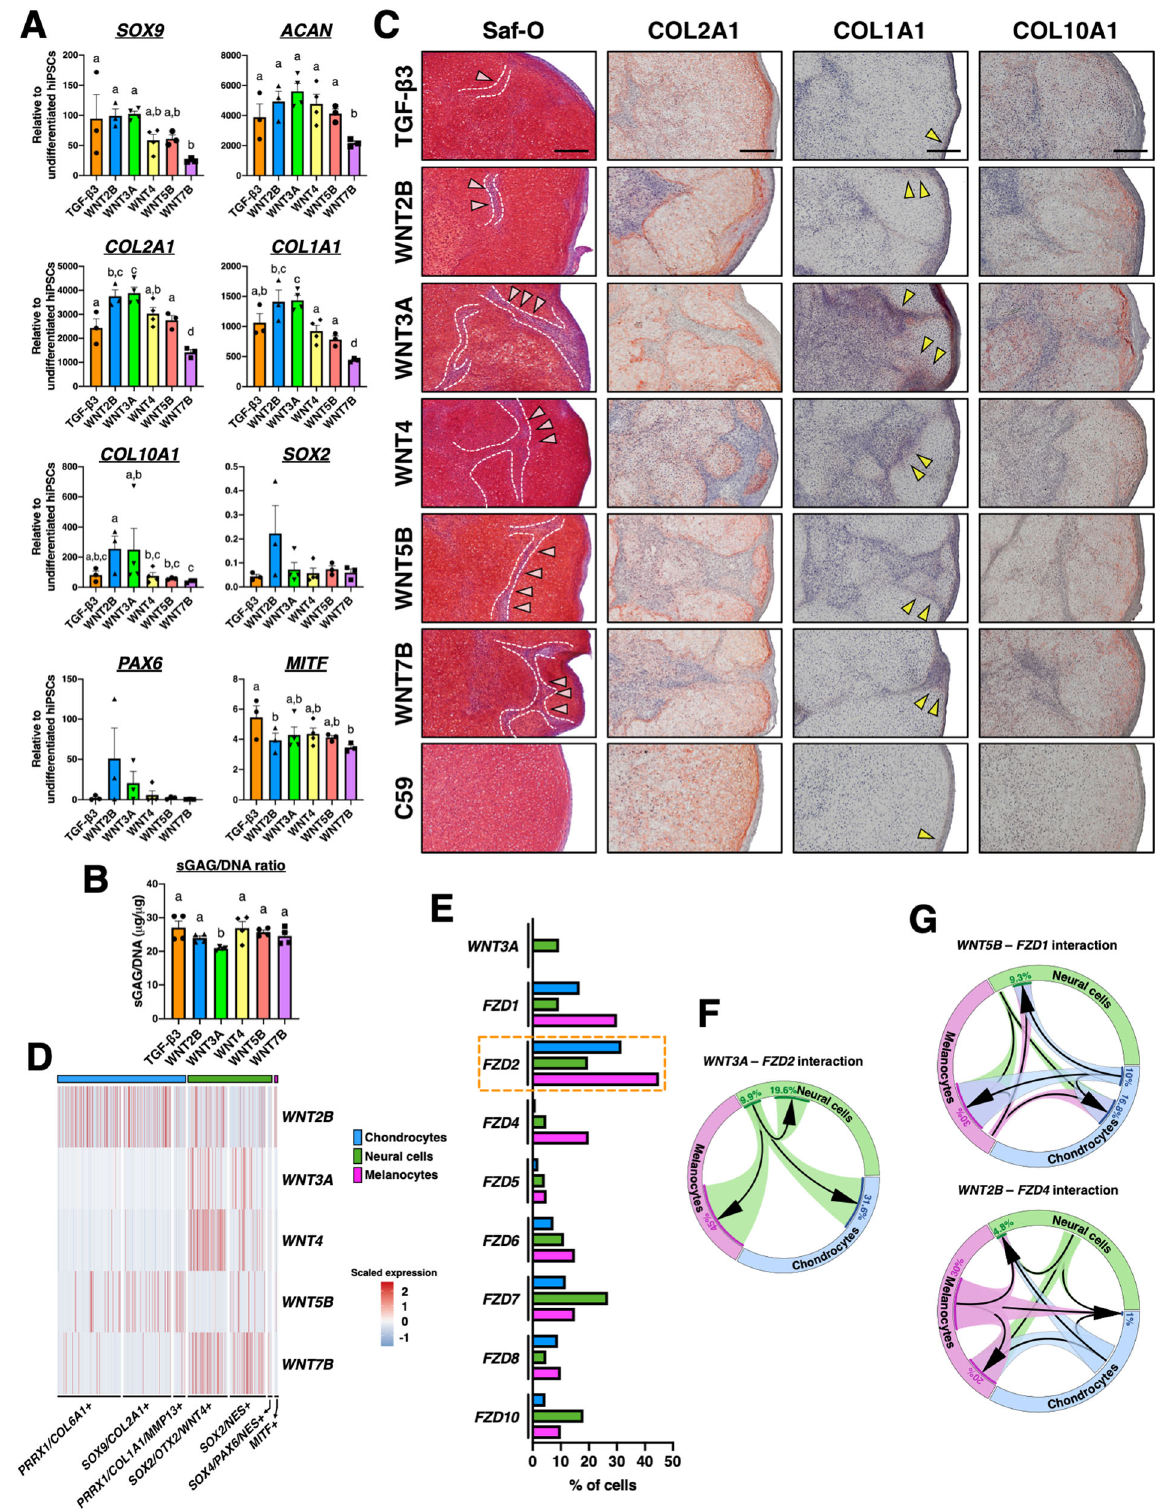
and ACTA2/PRRX1/COL1A1 + mesenchymal cells (Supplemen- tary Fig. 10A; CCA was performed with a total of 1335 cells from mesenchymal and chondrocyte populations from d14 TGF- β 3 pellets and with a total of 3047 cells from mesenchymal and chondrocyte populations from d14 C59 pellets. It is impor- tant to note that off-target cells (i.e., neural cells and